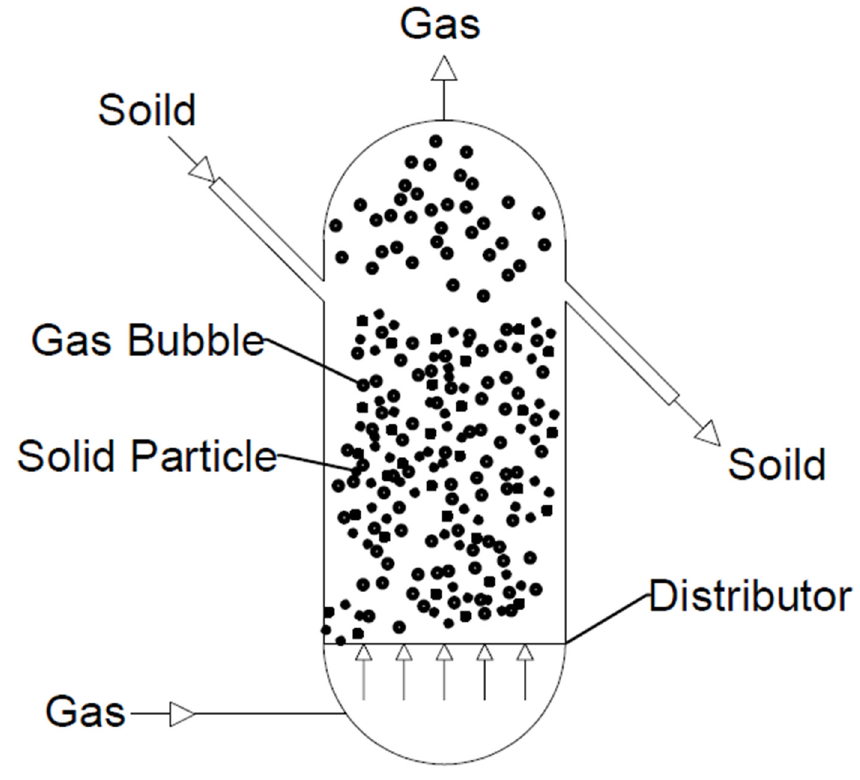
Figure 10. Scheme of a fluidised bed reactor. Developed based on [92]. (c) Isothermal adiabatic reactor